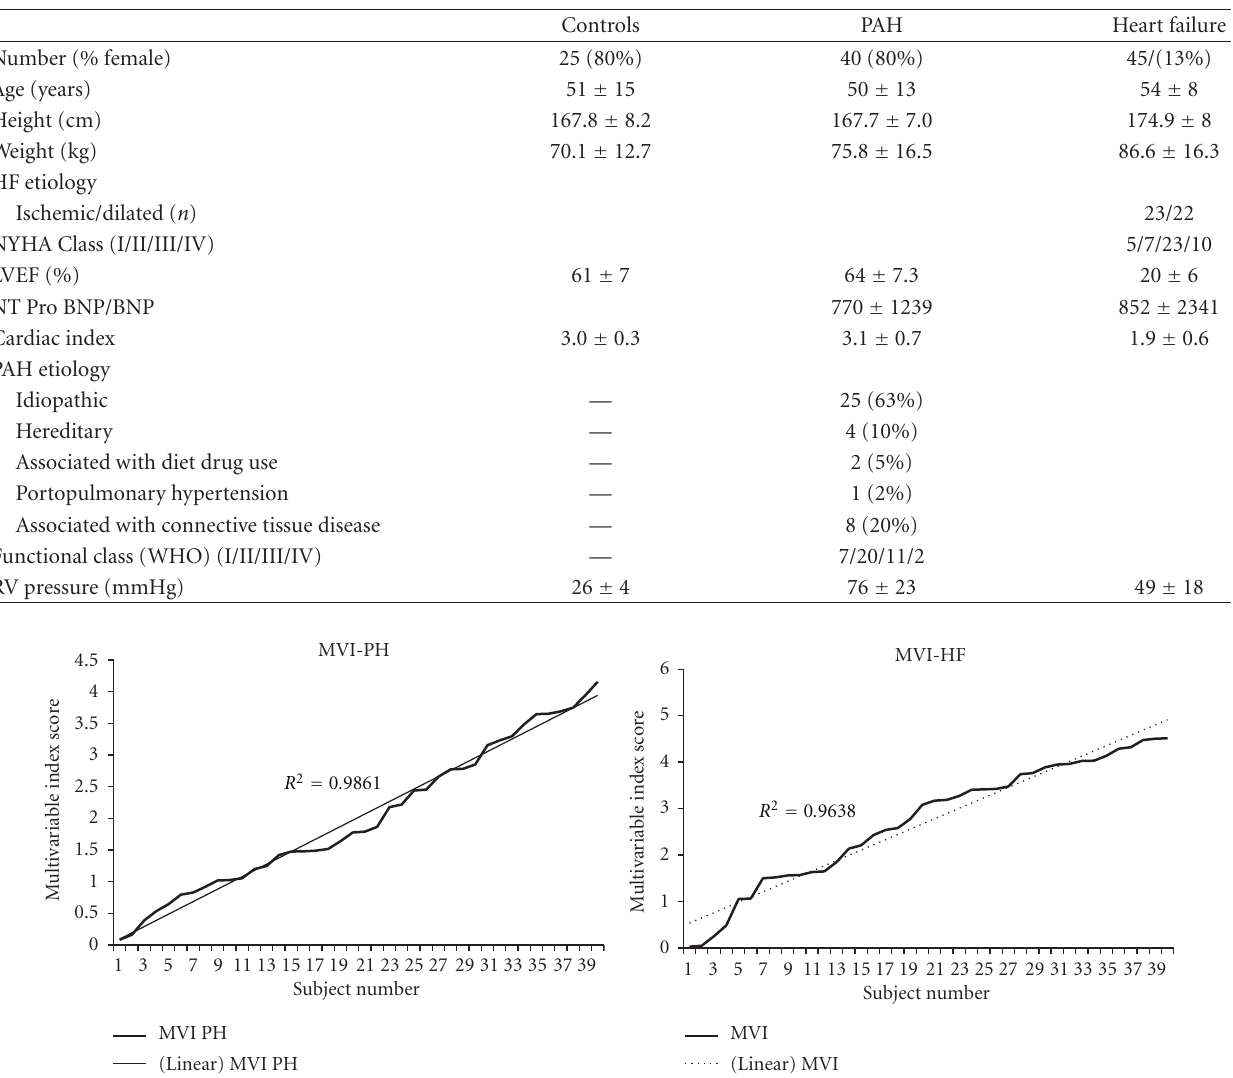
Table 5: Subject characteristics.